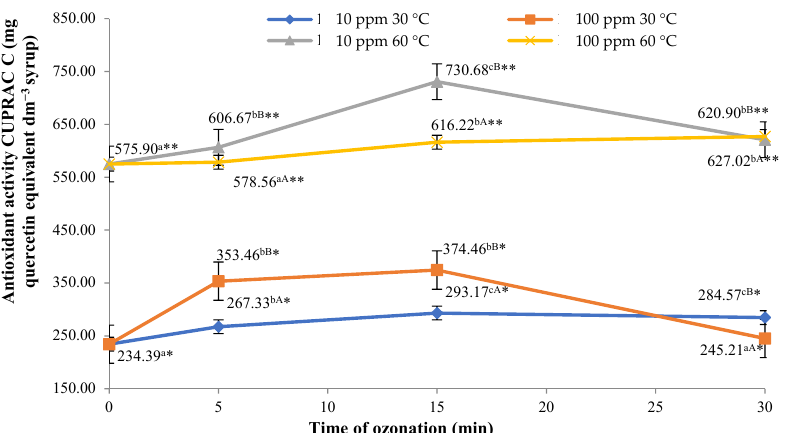
Figure 1. Antioxidant activity (CUPRAC method) identified in syrups from flowers of black elder, relative to the dose of ozone applied and temperature of sugar syrup used. Note: Differences in results between the time of ozonation (for certain ozone concentration) are indicated by different small letters, differences between ozone concentration (for certain ozonation time) are indicated by different capital letters and differences between sugar syrup temperatures are indicated by * or ** (for the same ozone-treatment conditions) at α < 0.05.